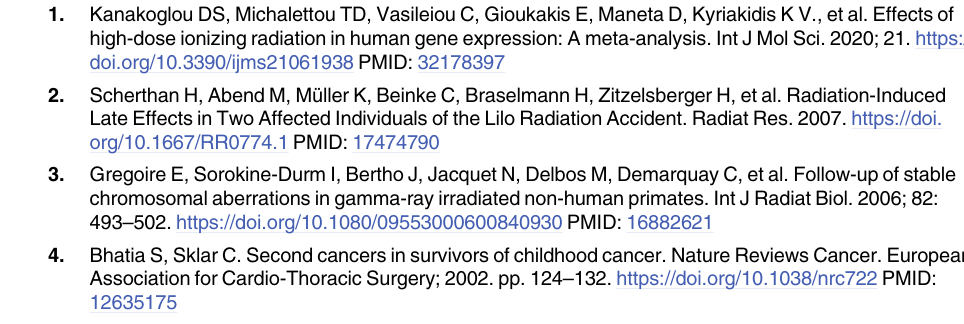
validated genes of the Baboon and Macaca mulatta experiment. Data is sorted by successful inter-species validation (14/41), no inter-species validation (23/41) and inverse inter-species validation (4/41). Successfully validated time points are shown in bold. S3 Table. Annotation of nine most promising genes for discrimination of post- from pre- exposure samples. A summary of the currently known function is given. Results for a Pubmed search (http://www.pubmed.gov) for “gene name” + “radiation” are